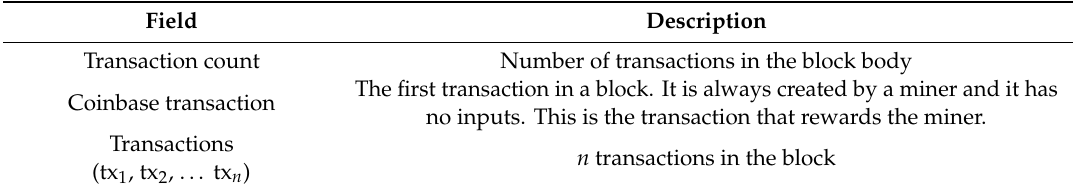
Table 4. Structure of the body part in the block.